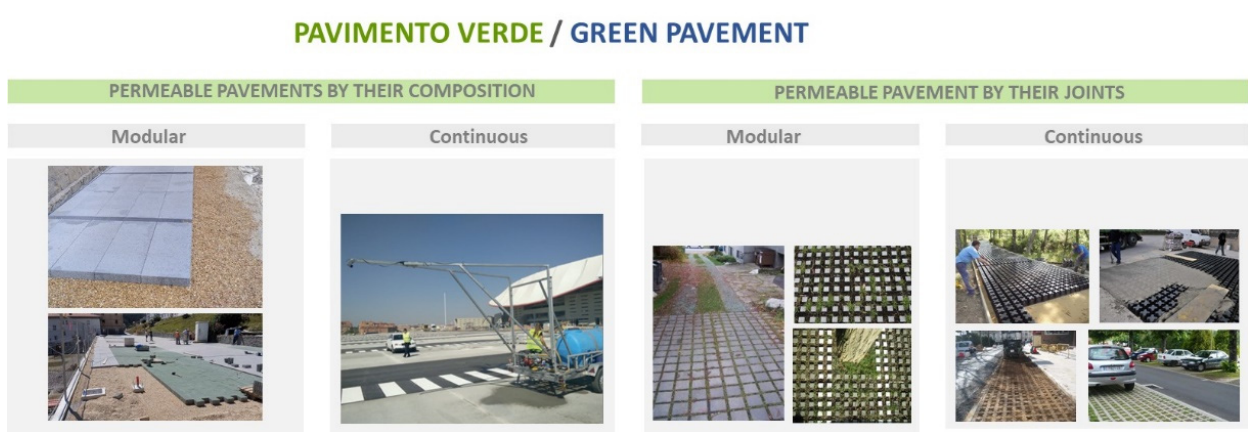
Figure A4. Types of green pavement (table and images by the authors, except images of continuous pavements [65,66]).